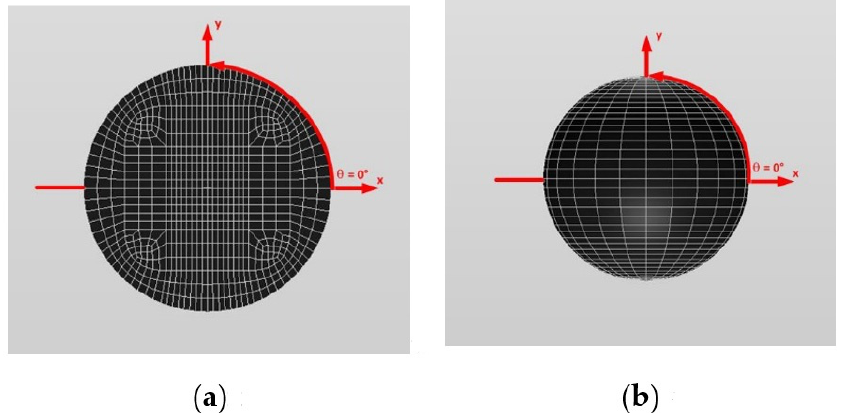
Table 8. Normalized tensile stress component ( σ xx / σ oxx ) within the isotropic spherical inclusion due to uniform remote tensile loading ( σ oxx ).